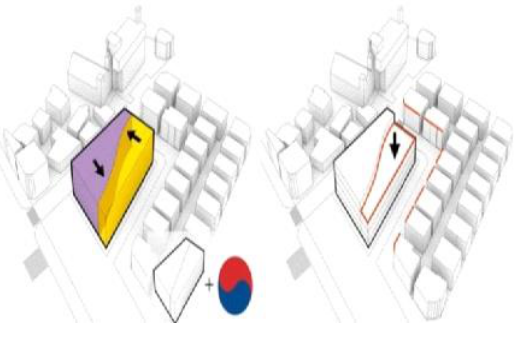
Fig. 12: Ying-Yang public library (competition). (Designboom, 2016)